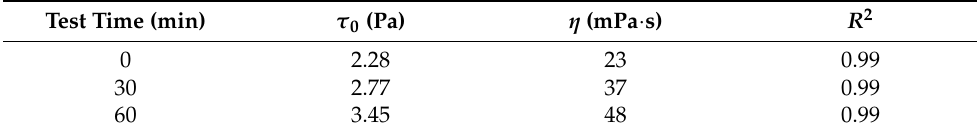
Table 6. Rheological parameters of the fresh slurry.